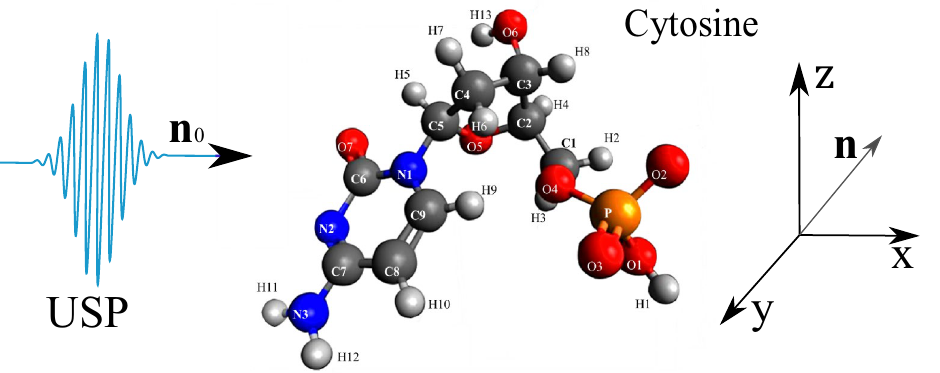
Figure 8. The cytosine on which the USP falls is represented, as well as the chosen coordinate system. The calculation was performed in the spatial orientation of the cytosine in relation to the USP in the chosen coordinate system shown in this